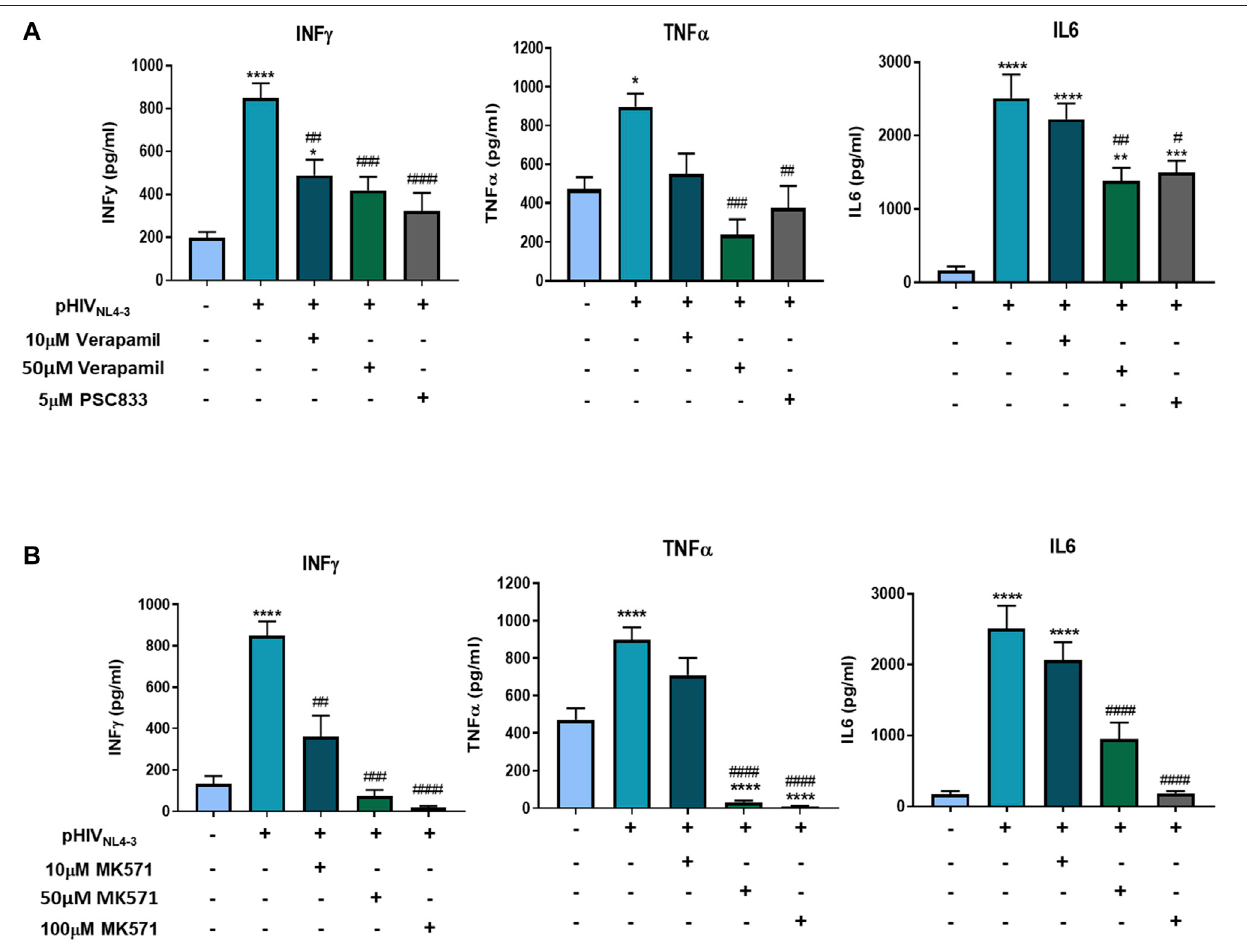
FIGURE6| P-gpandMRP1demonstrateinvolvementinproin fl ammatorycytokinesecretionfollowingpHIV NL4-3 exposure.TheeffectsofP-gpinhibitorsverapamil and PSC833 (A) or MRP1 inhibitor MK571 (B) on the release of proin fl ammatory cytokines from pHIV NL4-3 exposed PBMCs. Supernatants were collected from cells exposed tovehicle,pHIV NL4-3 only, orpHIV NL4-3 in thepresence ofinhibitorsfor48 h. Results areexpressed asmean ± SEMofexperiments performed incells obtained from three donors ( n (cid:2) 3 donors). Multiple comparisons were performed using one-way ANOVA and Bonferroni ’ s post-hoc analysis; p < 0.05 was considered statistically signi fi cant. *, statistically signi fi cant difference compared to untreated control; #, statistically signi fi cant difference compared to pHIV NL4-3 only. *, p < 0.05; **, p < 0.01; ***, p < 0.001; ****, p < 0.0001; #, p < 0.05; ##, p < 0.01; ###, p < 0.001; ####, p < 0.0001.